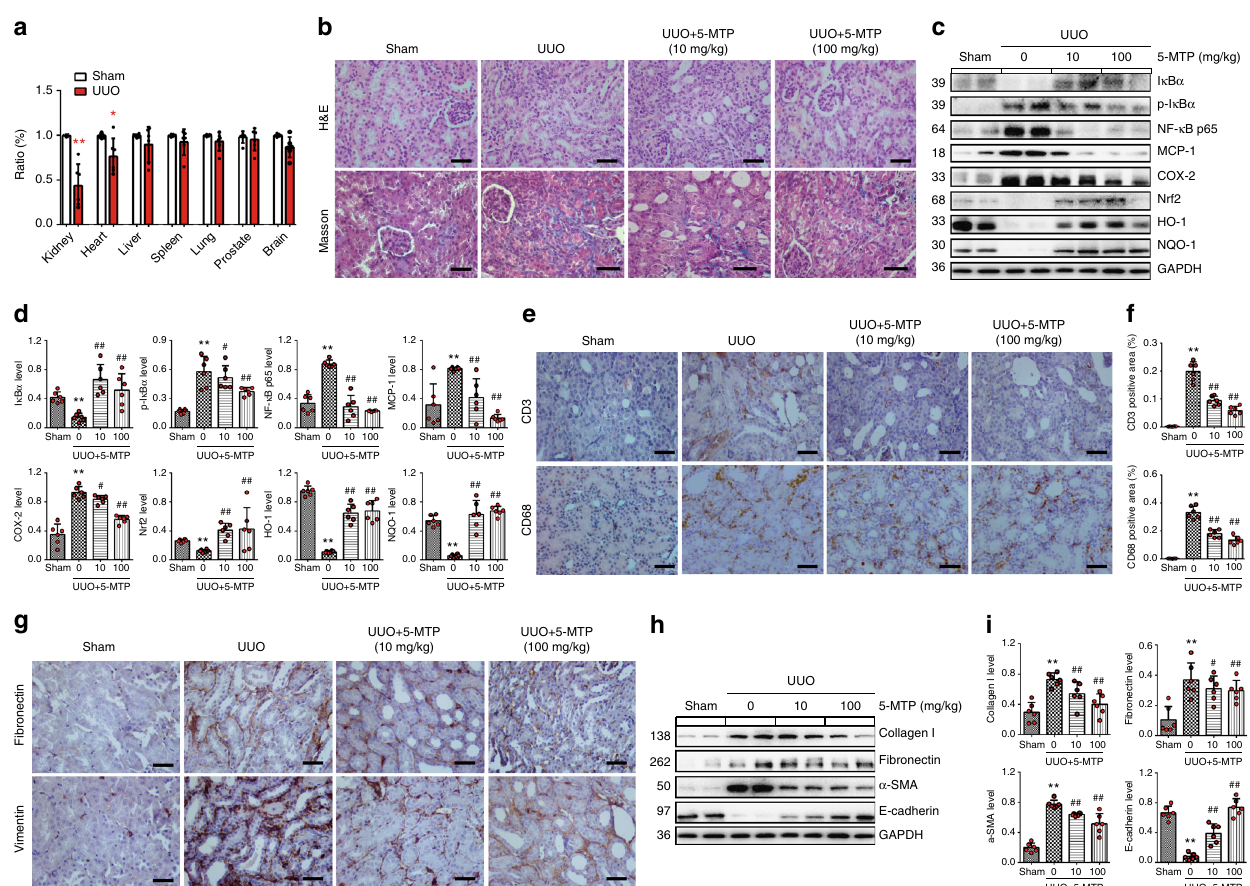
Fig. 6 The anti-in fl ammatory and anti- fi brotic effects of 5-MTP in vivo. a The level of 5-MTP in the different tissues in UUO mice. * P < 0.05, ** P < 0.01 compared with sham group ( n = 6). b H&E and Masson trichrome staining of kidney tissues of UUO mice. Representative micrographs showed kidney in fl ammation and fi brotic lesions in indicated groups. Paraf fi n sections were used for H&E and Masson trichrome staining. Scale bar, 55 μ m. c , d The protein expression and relative quantitative data of I κ B α , p-I κ B α , NF- κ B, and its downstream gene products, COX-2, MCP-1, as well as Nrf2 and its downstream gene products, HO-1 and NQO-1, in indicated groups. * P < 0.05, ** P < 0.01 compared with sham group ( n = 6). # P < 0.05, ## P < 0.01 compared with UUO group ( n = 6). e , f Immunohistochemical staining of CD3 and CD68 and relative quantitative data in indicated groups. Scale bar, 50 μ m. # P < 0.05, ## P < 0.01 compared with UUO group ( n = 6). g Immunohistochemical staining of fi bronectin and vimentin in indicated groups. Scale bar, 50 μ m. h , i The protein expression and relative quantitative data of collagen I, fi bronectin, α -SMA and E-cadherin in different groups as indicated. * P < 0.05, ** P < 0.01 compared with sham group ( n = 6). # P < 0.05, ## P < 0.01 compared with UUO group ( n = 6). UUO, unilateral ureteral obstruction. Dot presents the single data results in bar graph. Data are presented as means ± SD. Student ’ s t test was used for the signi fi cance of difference between two groups; one-way ANOVA followed by Dunnett ’ s post hoc test for multiple comparisons was used for three or more